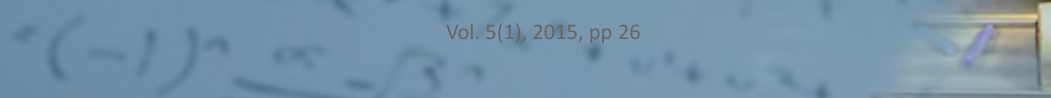
Vol. 5(1), 2015, pp